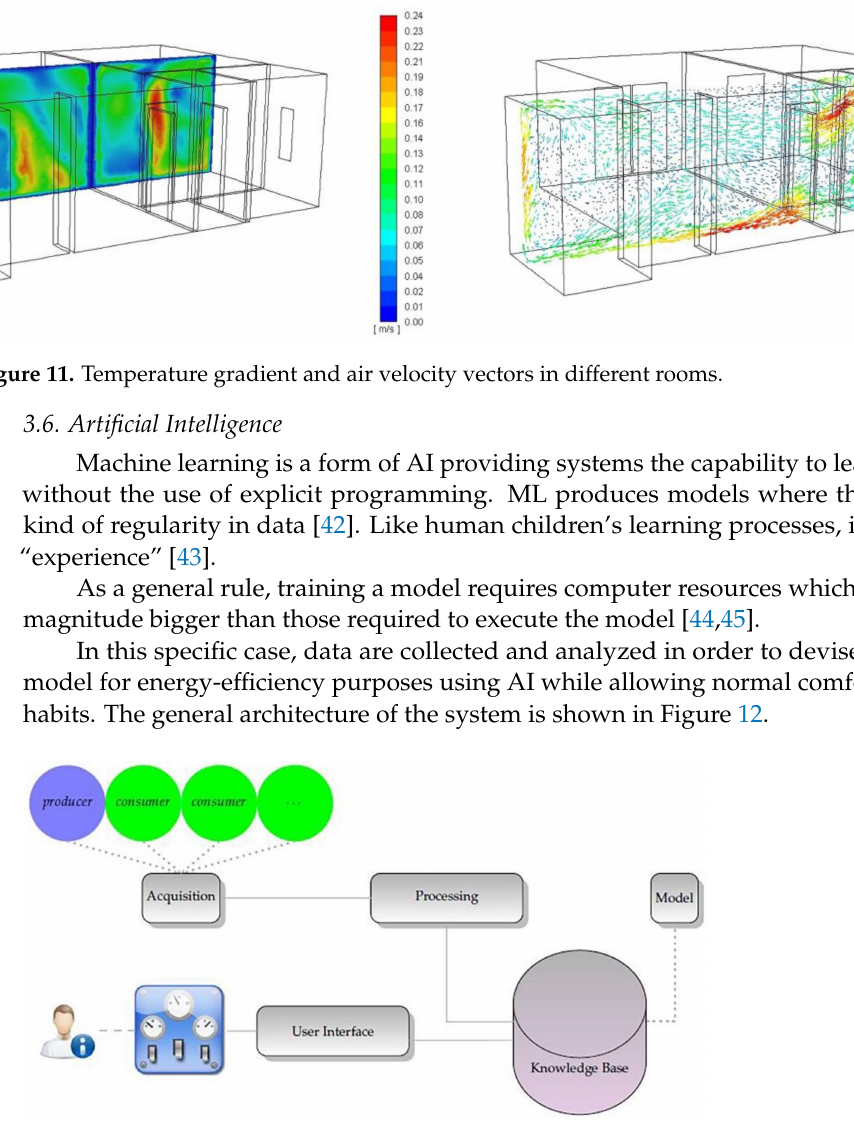
Figure 12. System